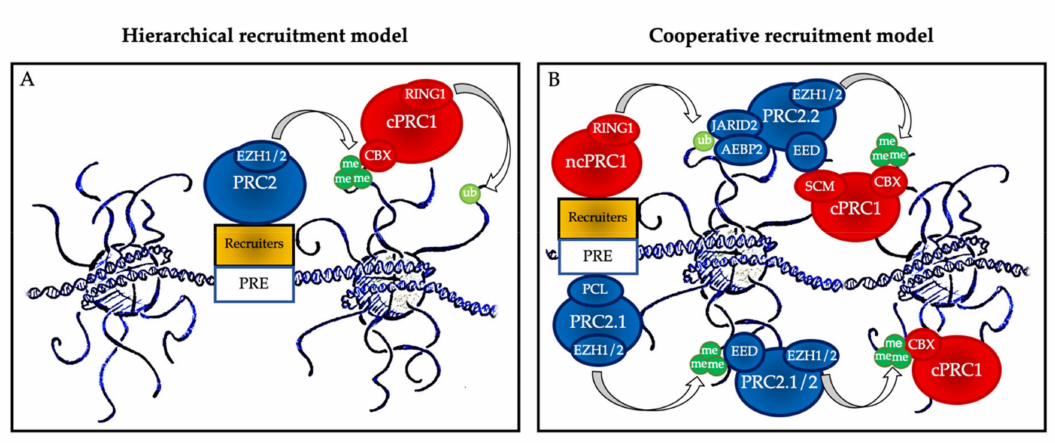
Figure 2. Polycomb group protein chromatin recruitment models. ( A ) Hierarchical recruitment model: PRC2 is recruited first and deposits H3K27me3 on chromatin via its catalytical subunit EZH1 or EZH2; then, canonical PRC1 (cPRC1) is recruited by a chromobox member CBX on the H3K27me3 mark and deposits H2AK119ub1 on chromatin via its catalytical subunit RING1. ( B ) Cooperative recruitment model: ncPRC1 complexes deposit H2AK119ub, which recruits PRC2.2 via its JARID2 and AEBP2 subunits. In parallel, PRC2.1 is recruited to unmethylated CpG island DNA via its PCL